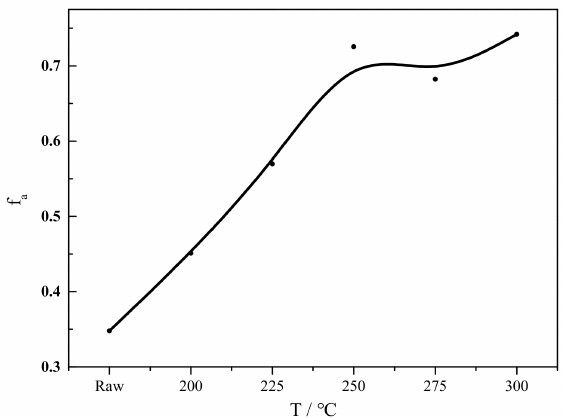
Figure 2. Variation of aromaticity with the torrefied temperature increasing.